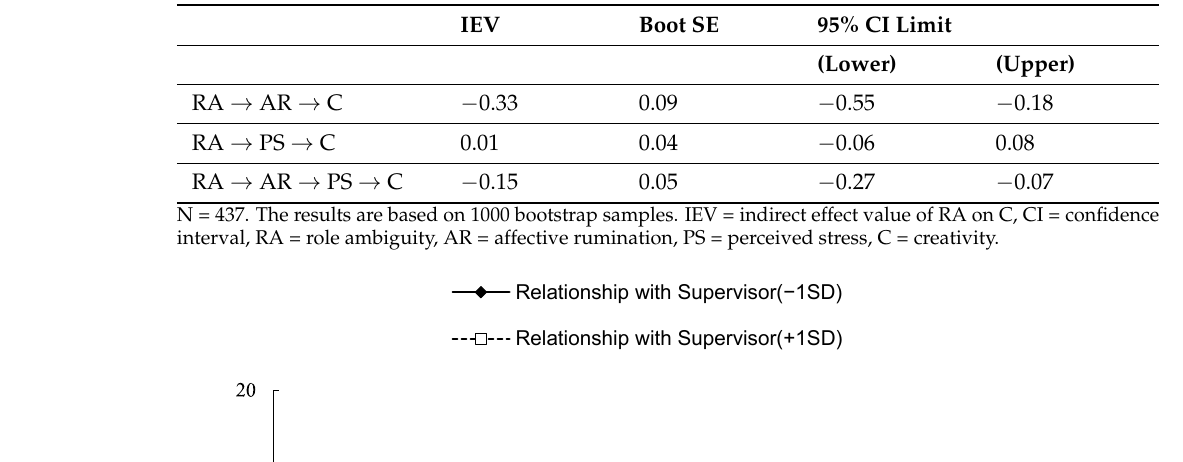
Table 3. Bootstrapping indirect effect and 95% confidence interval (CI) for the mediation model.